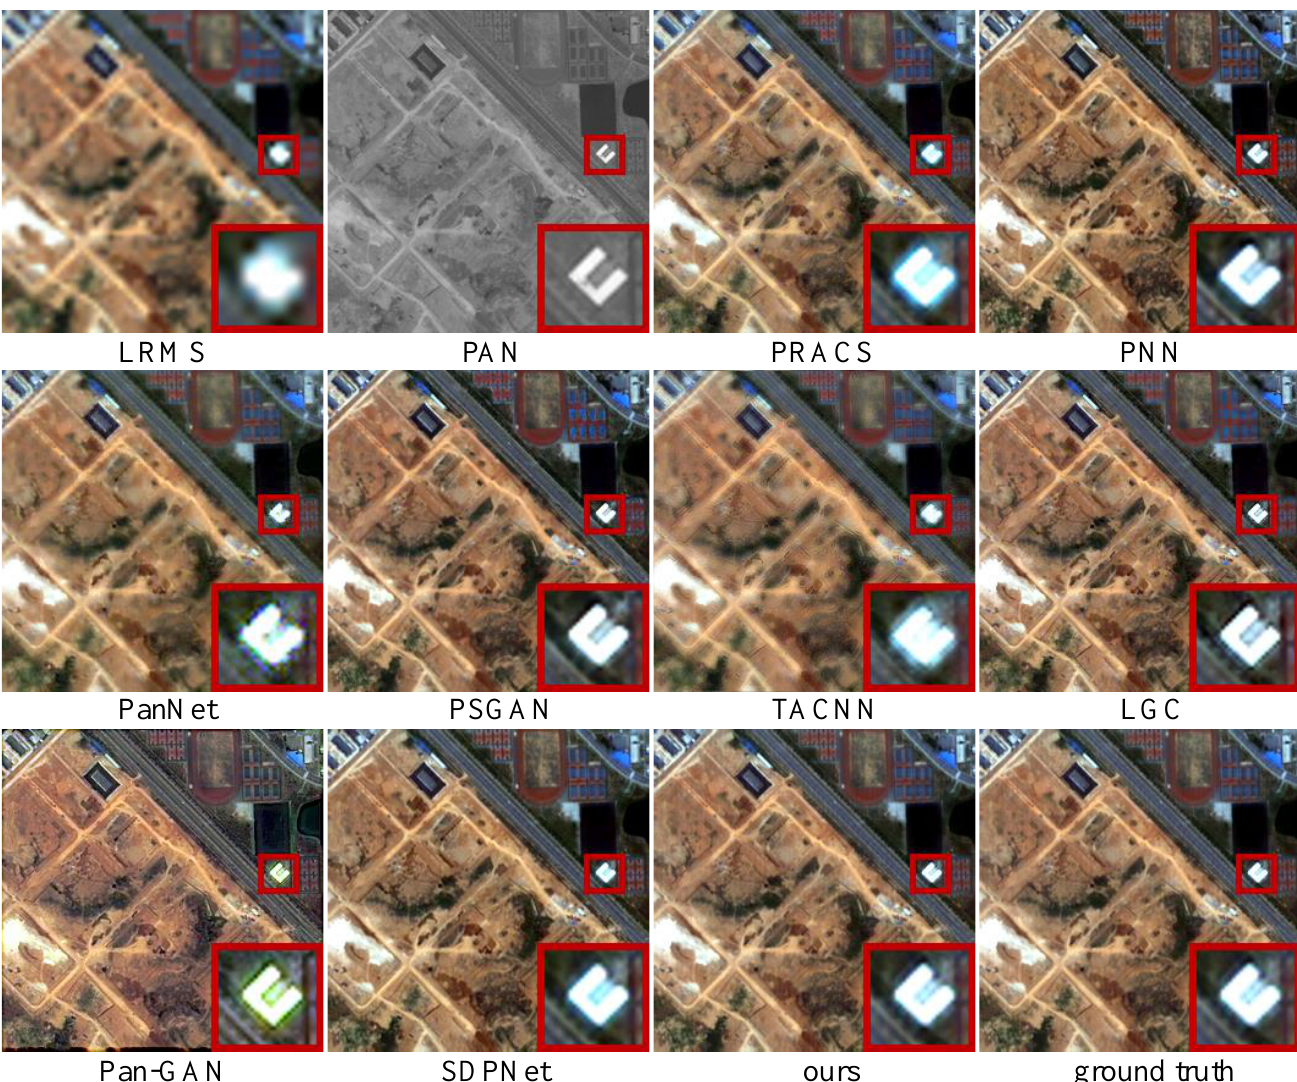
Figure 6. Qualitative comparison of CPNet with other eight pan-sharpening methods on the data from the QuickBird data